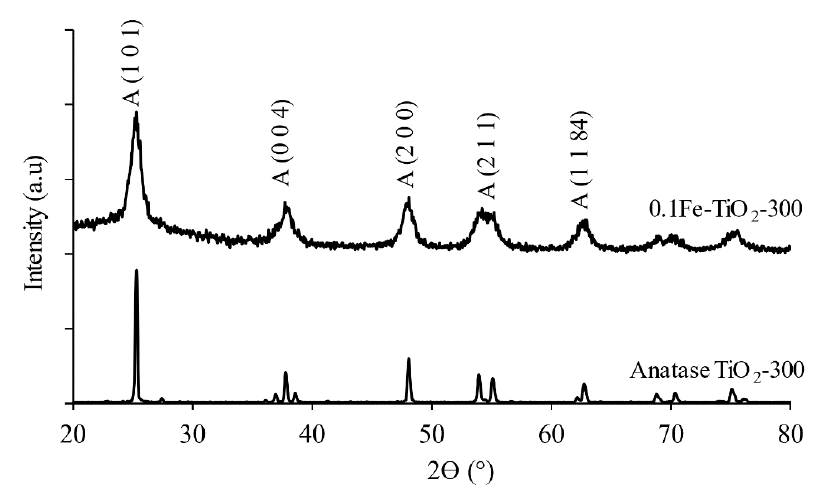
Figure 3. XRD peaks of anatase TiO 2 -300 and 0.1Fe-TiO 2 -300.